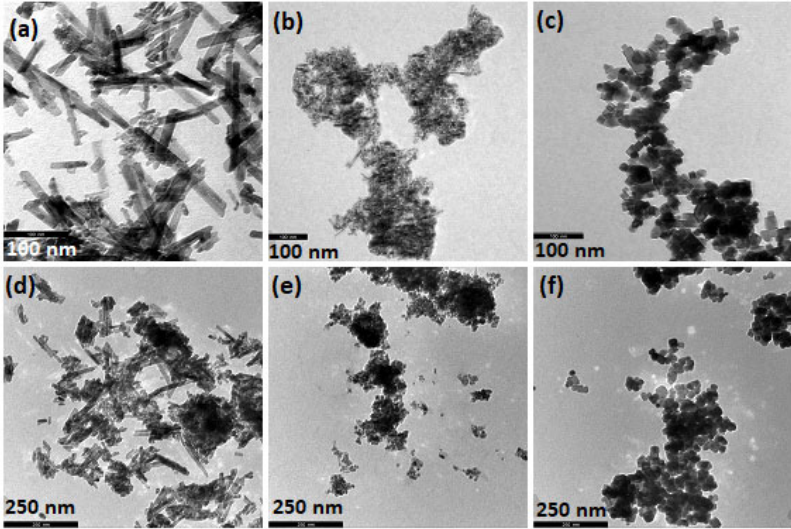
Figure 3. TEM images of the samples: ( a ) CeO 2 -NR, ( b ) CeO 2 -NP, ( c ) CeO 2 -NC, ( d ) Fe 2 O 3 / CeO 2 -NR, ( e ) Fe 2 O 3 / CeO 2 -NP, and ( f ) Fe 2 O 3 / CeO 2 -NC.